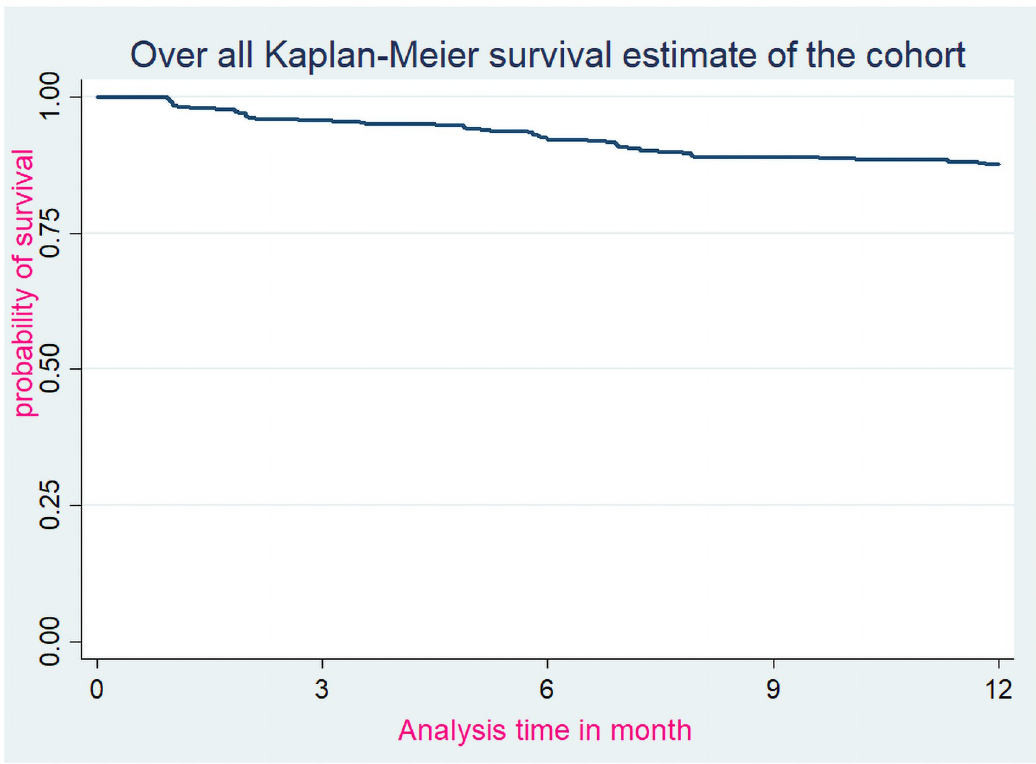
Fig 1. Over all Kaplan-Meier survival curve from ART initiation to death within one year follow-up period among adults on ART at Debre-Markos Referral Hospital from Jan 1, 2014 to Dec 31, 2018.